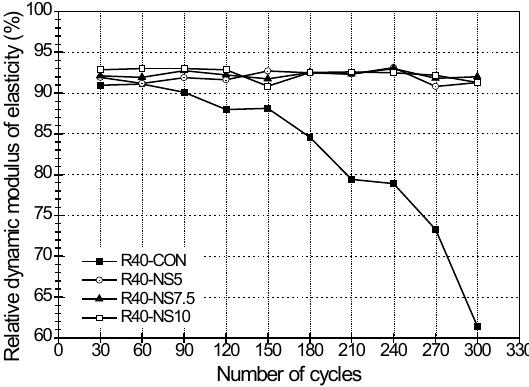
Figure 4. Relative dynamic modulus of elasticity by freezing-thawing cycles.